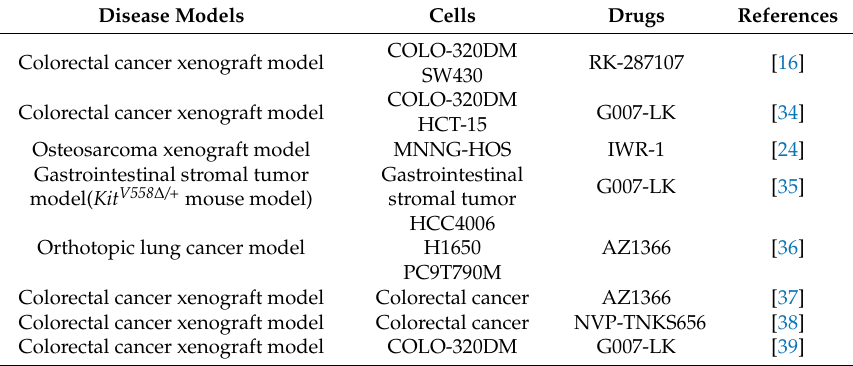
Table 1. Preclinical studies of tankyrase inhibitors with in vivo murine cancer models.